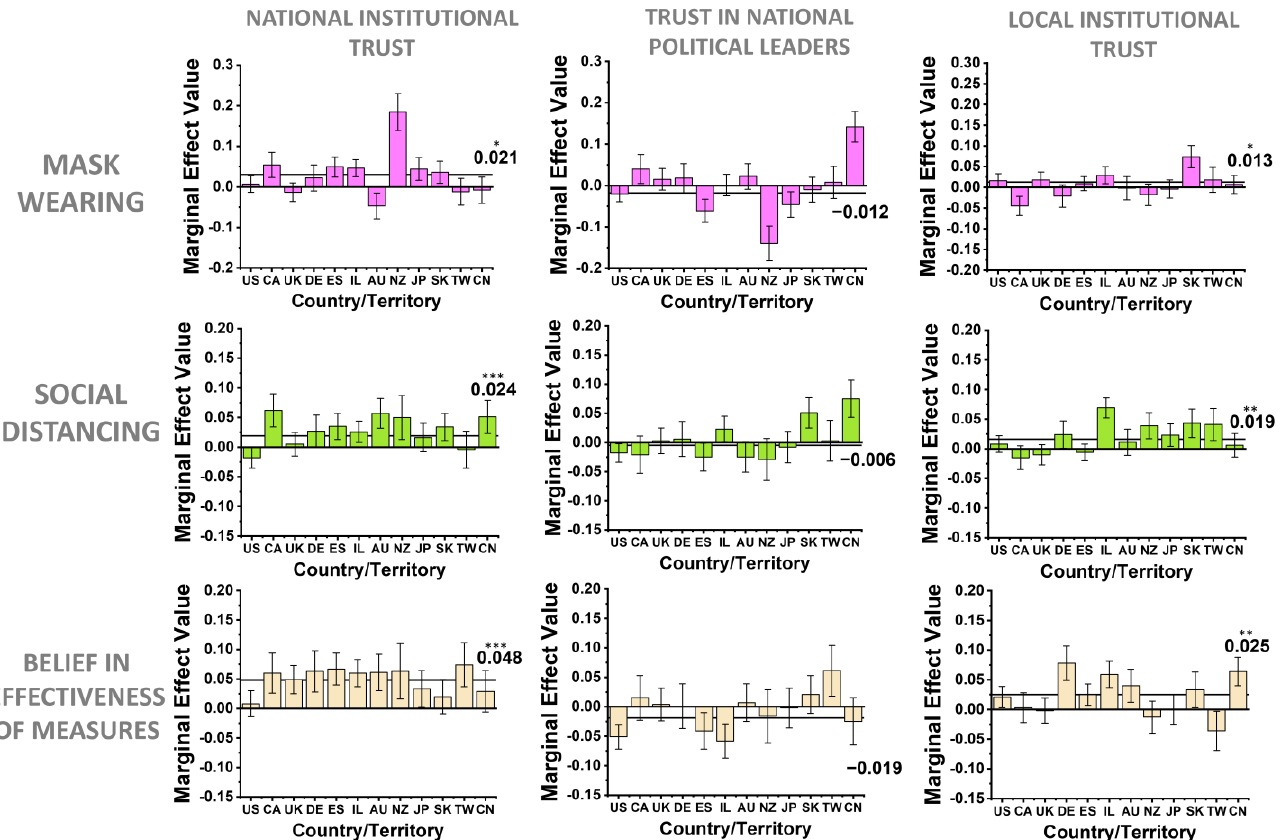
Figure 2. Per country/territory marginal effects for government-related trust components’ influence on public health actions and beliefs. Heterogenous per country/territory marginal effects for the government-related trust categories of national institutional trust in public health agencies, trust in national political leaders, and trust in local institutions (hospitals and officials), for each public health behavior variable: mask wearing, social distancing, and belief in the effectiveness of public health measures. Independent variables only are standardized; dependent variables are kept as percentages (0 to 1 normalized scale). Error bars are standard errors of the mean, and the global coefficient value from Table 1 is marked with the horizontal line on each plot (* p < 0.10; ** p < 0.05; *** p < 0.01). Standard ISO 3166 abbreviations for each country/territory are used.